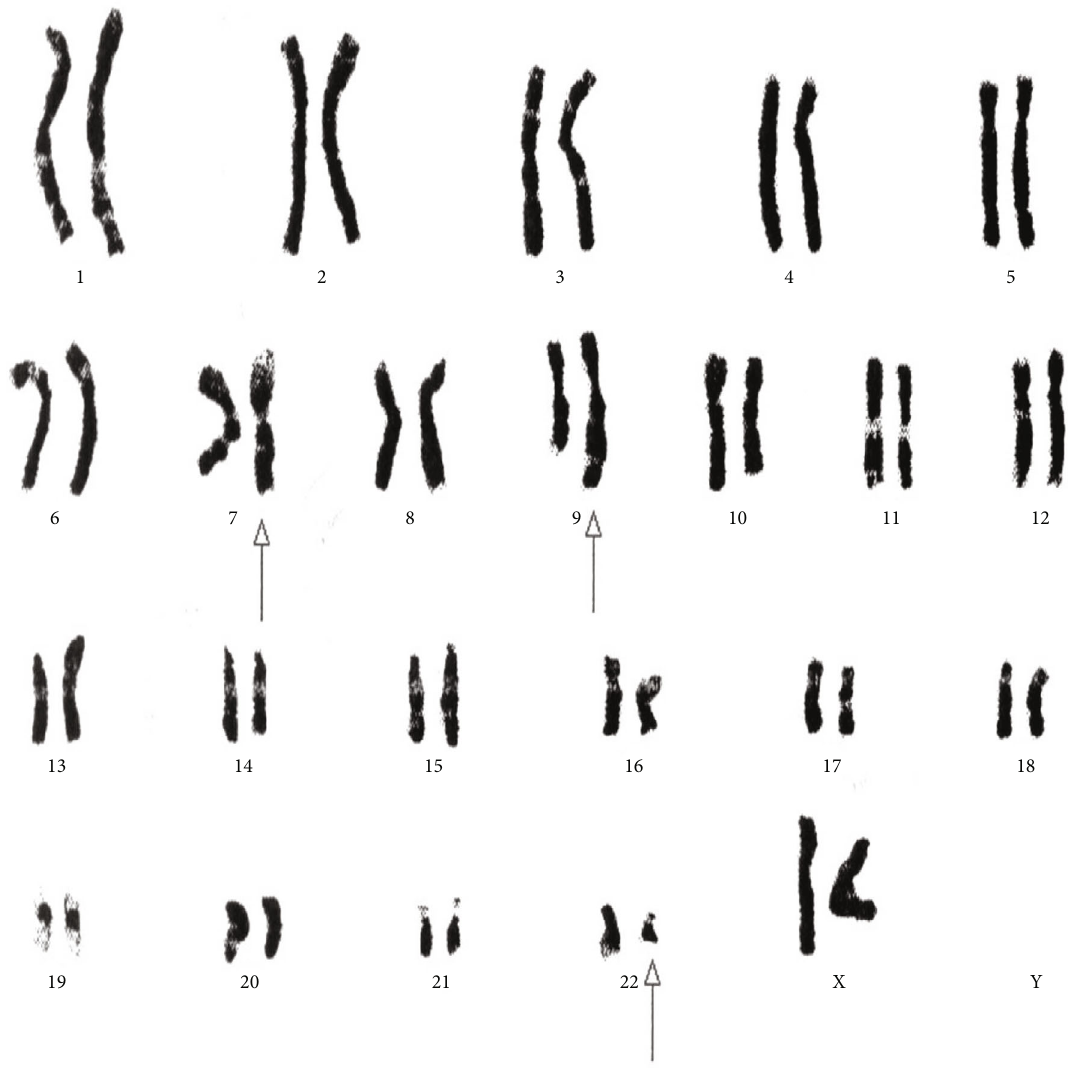
Figure 2: Cytogenetic analysis shows a variant three-way translocation 46XX,t(7;9;22)(p13;q34;q11.2)